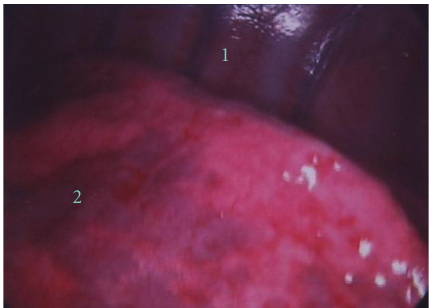
Figure 1: The thoracoscopic image shows the pleura overlaying the tissue and organs in the thoracic cavity: chest wall (1) and the lung (2).